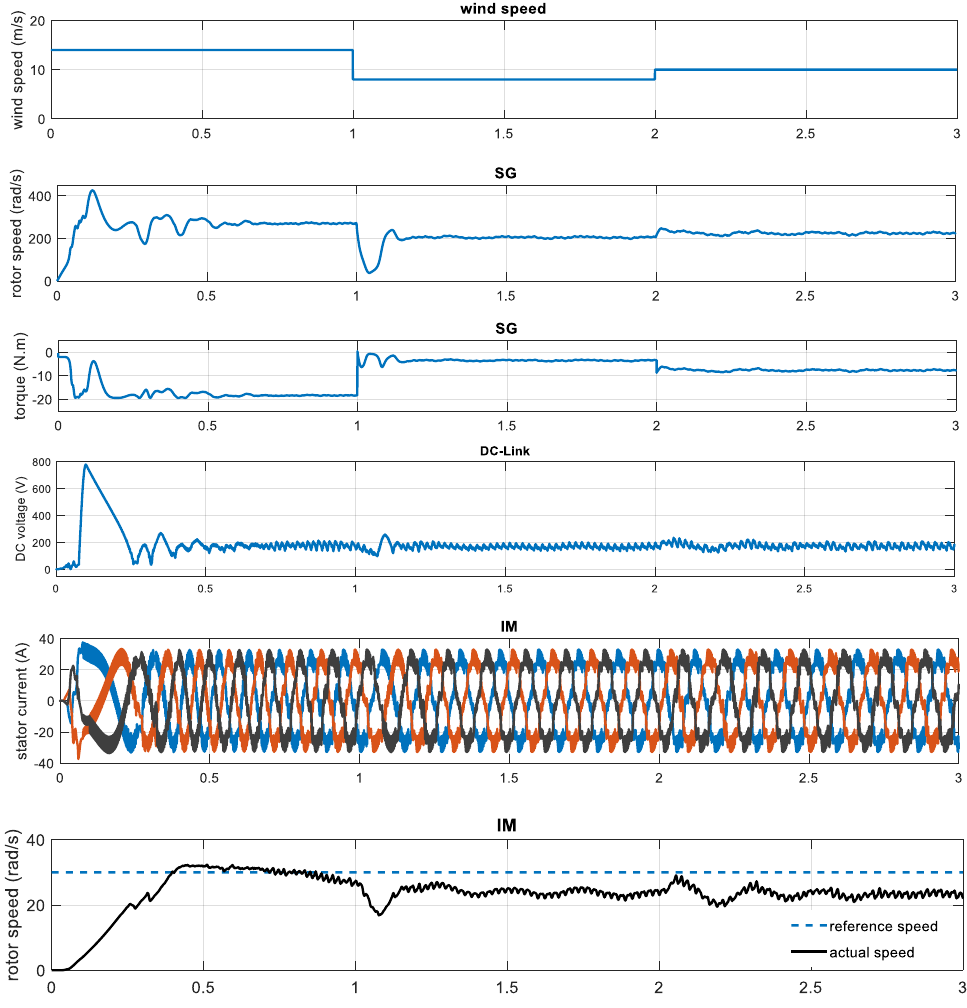
Figure 7. E ff ective reaction of autonomous wind / storage production component providing IM with the Figure 7. Effective reaction of autonomous wind/storage production component providing IM with conventional PID control for step variations in velocity of the the conventional PID control for step variations in velocity of the wind.